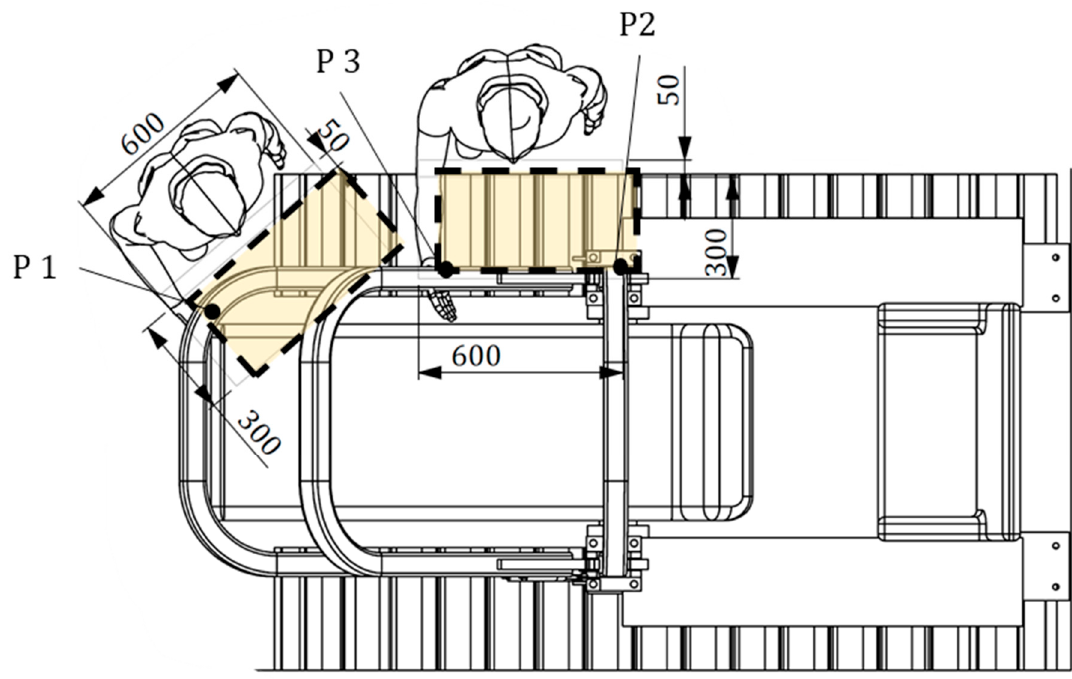
Figure 6. Top view of the tractor and positions of the operator when handling the FROPS (measures are expressed in mm).